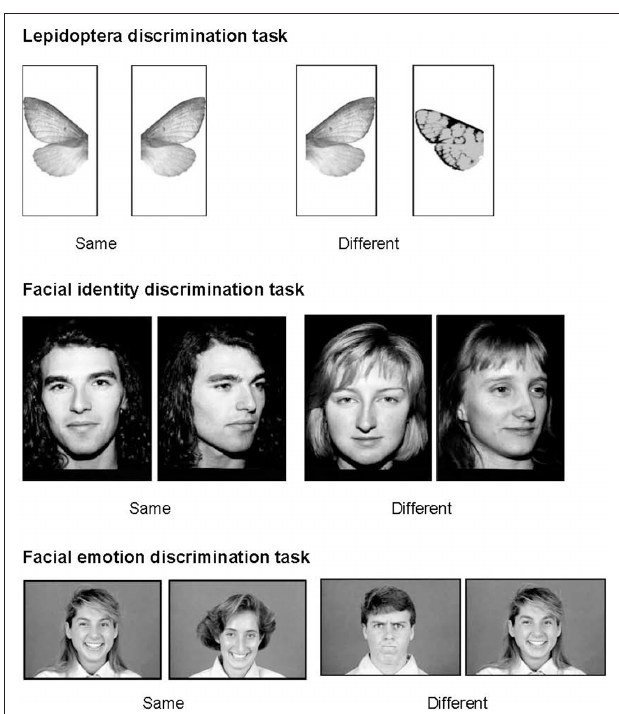
Figure 1 | examples of same and different stimulus pairs from each of the three